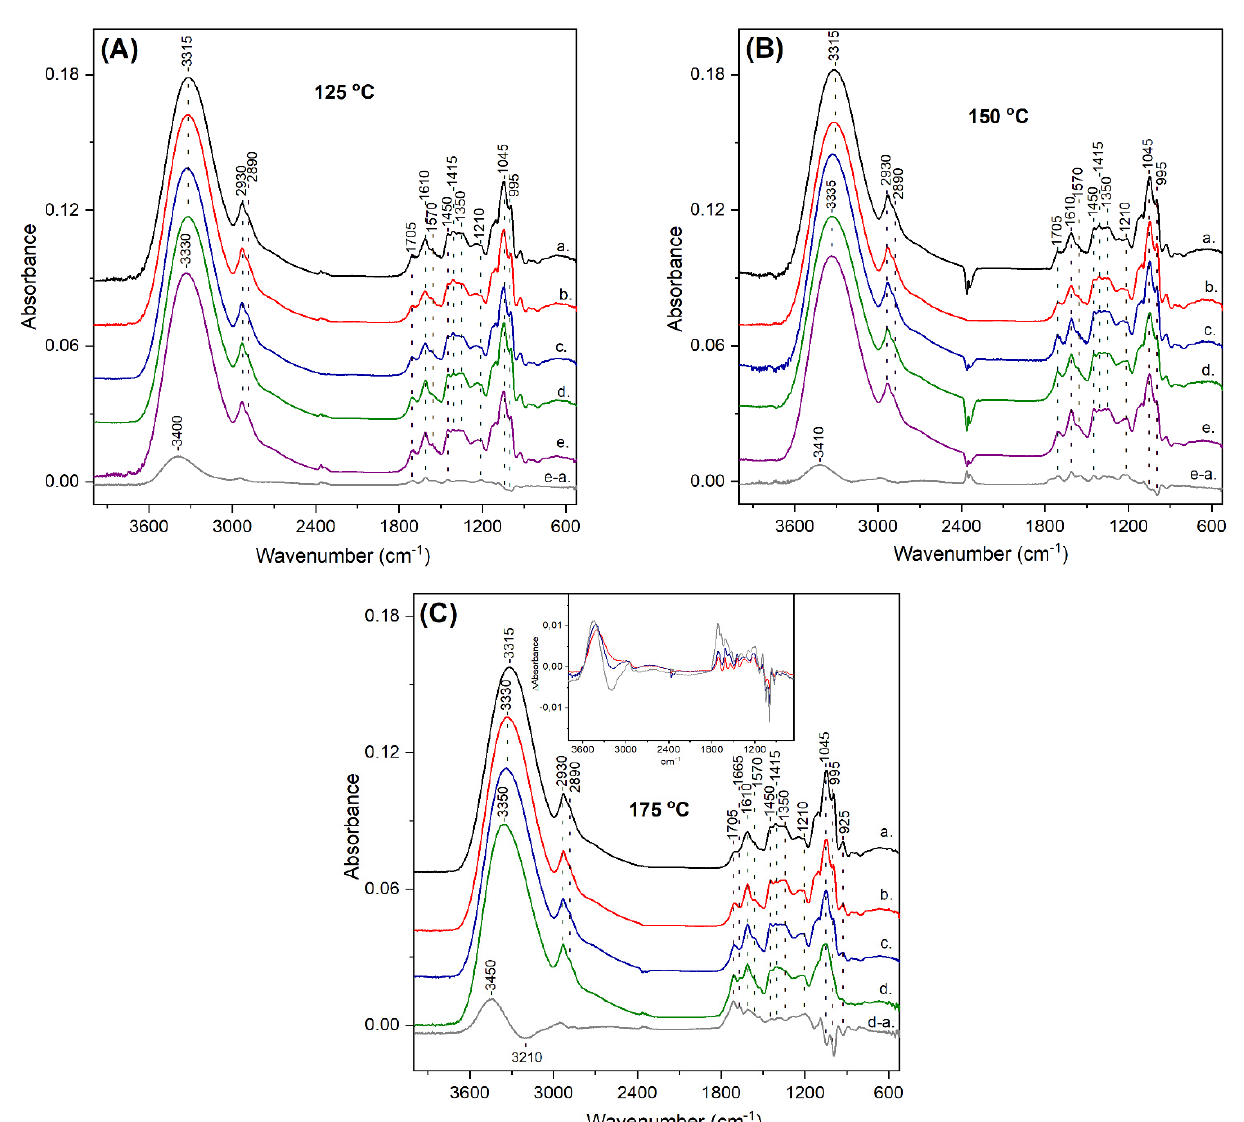
Figure 5. ATR-FTIR spectra of carob powder extracts obtained prior to (trace a) and after the roasting of kibbles for 15 min (trace b), 30 min (trace c), 45 min (trace d) and 60 min (trace e) at the indicated temperatures in each panel: ( A ) 125 °C, ( B ) 150 °C and ( C ) 175 °C. The spectra in all panels have been translated along the vertical axis for clarity. The difference FTIR spectrum of the extract from the longer roasting time minus the unroasted sample (trace e − a in panels A and B and trace d − a in panel C) is included in all panels. The inset in panel C shows the FTIR difference spectra: b − a (red), c − a (blue) and d − a (grey) in an overlay plot.